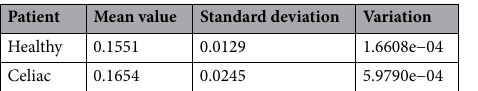
Table 7. Interpretation of the average variation of blue spectrum.